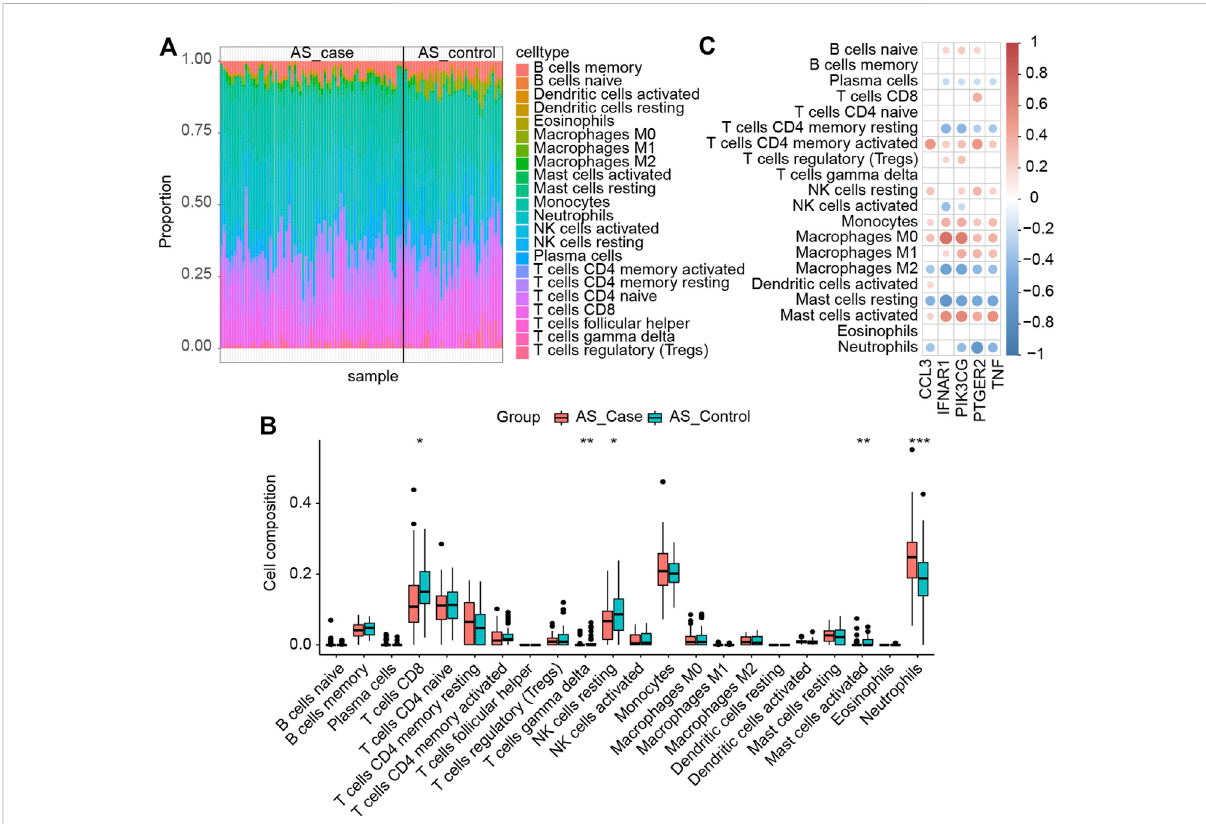
FIGURE 11 (A) Immune in fi ltration of each sample; (B) Comparison of immune cells between the two groups ( p : p -value < 0.05, pp : p -value < 0.01, ppp : p -value < 0.001); (C) Correlation between immune cells and key